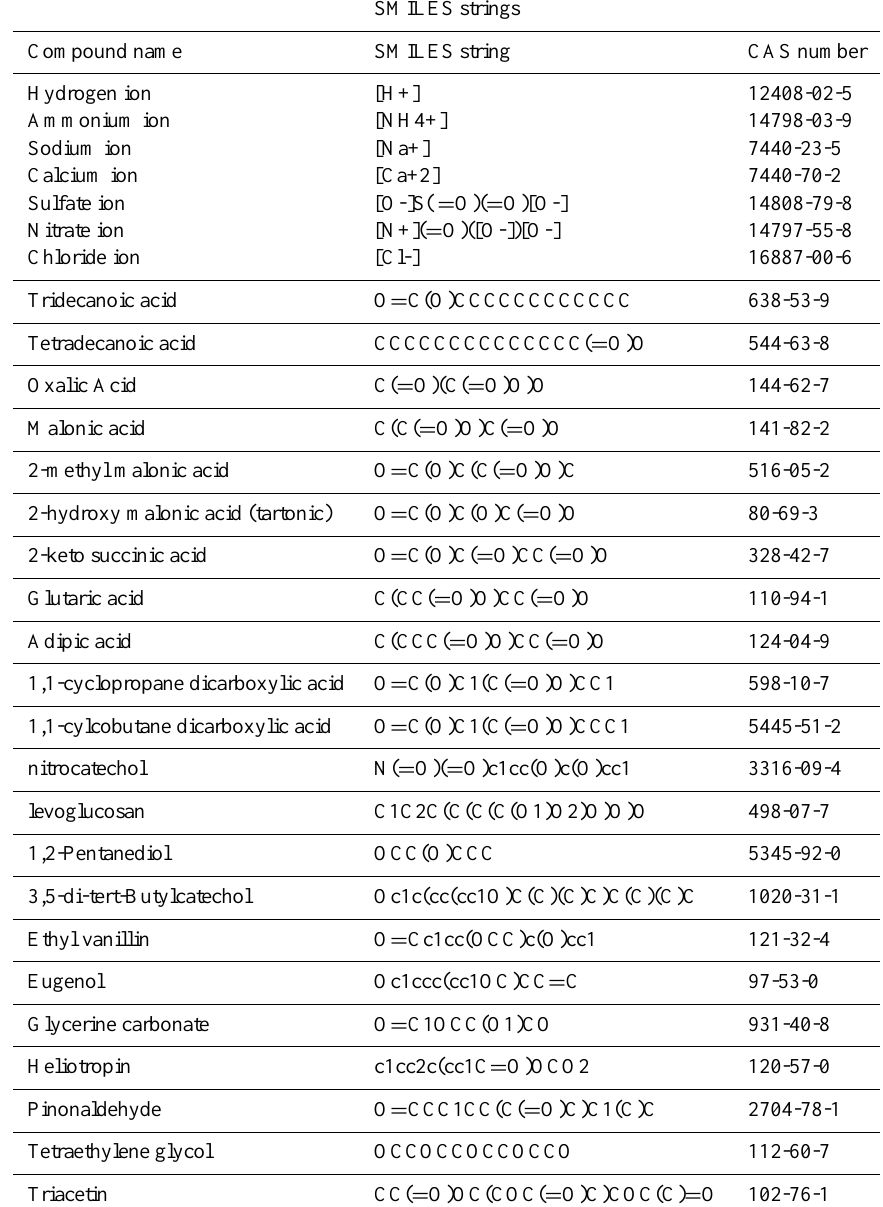
Table 1. Example SMILES of common inorganic ions and organic compounds with associated CAS (Chemical Abstracts Service) numbers. Please note, CAS numbers cannot be used directly in the prediction